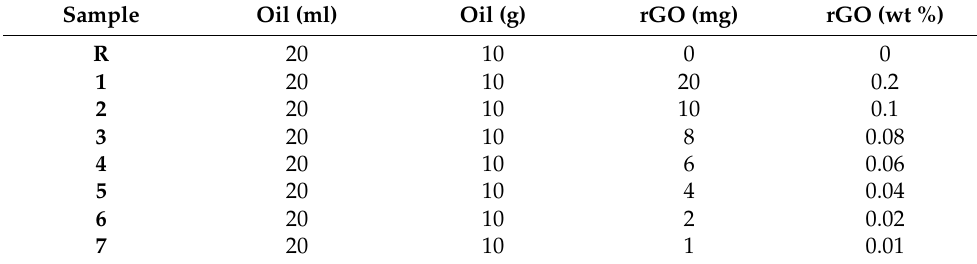
Table 2. Samples